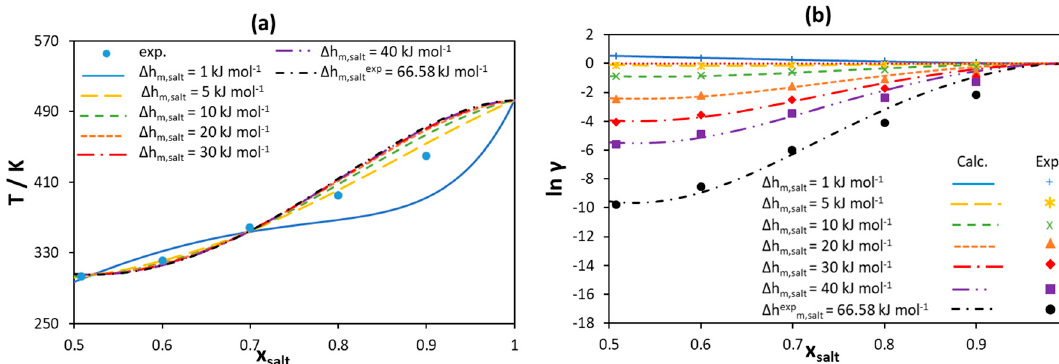
Figure 12. ( a ) [N 3333 ]Cl liquidus line for a [N 3333 ]Cl / palmitic acid binary mixture modeled using the Redlich–Kister polynomial with three parameters assuming di ff erent melting enthalpy values. ( b ) Activity coe ffi cients of [N 3333 ]Cl in the liquid phase calculated using the Redlich–Kister polynomial assuming di ff erent melting enthalpy values. Experimental data taken from [46] .